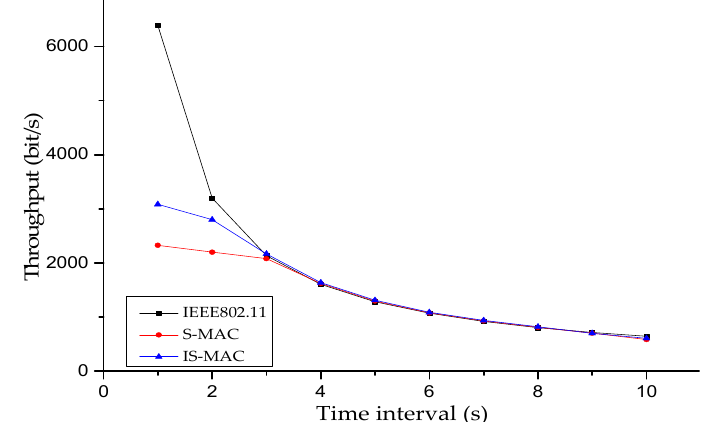
Figure 6. Throughput under different loads.